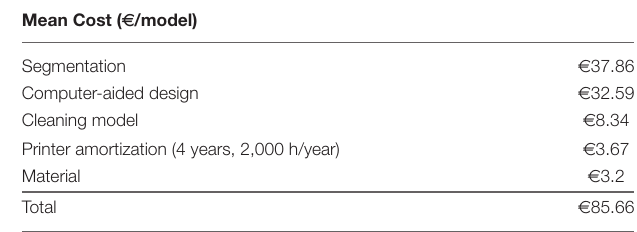
TABLE 3 | Mean cost of the design and fabrication